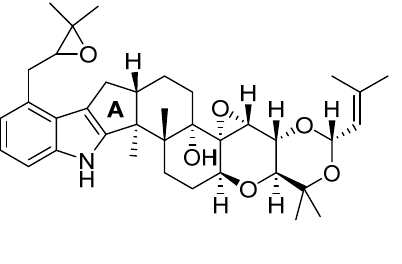
Figure 6. The structures of the indoles and indole alkaloids isolated from mushrooms ( 73 – 91 ). The three N -glucosylated indoles 76 – 78 (Figure 6) were isolated from the basidiomycete C. brunneus , with 76 and 77 being new compounds [49]. The endogenous role of compound 78 was investigated, and it was suggested that it may either act as an inactive transport or storage form of auxin (growth regulator), or that it is a detoxification product [49]. Macrolepiotin ( 79 , Figure 6) was isolated from Macrolepiota neomastoidea , a poisonous mushroom that causes severe gastrointestinal symptoms [50].